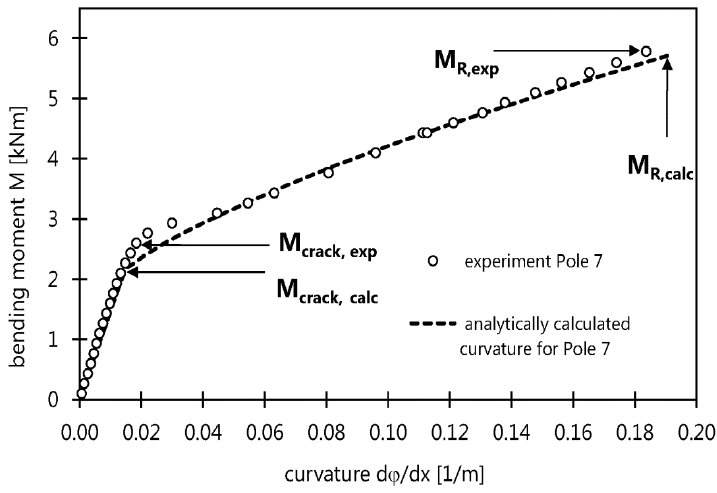
Figure 3. Quasi-static bending behavior of CFRP prestressed HPSC pole No. 7: Comparison of measured with calculated moment vs. curvature